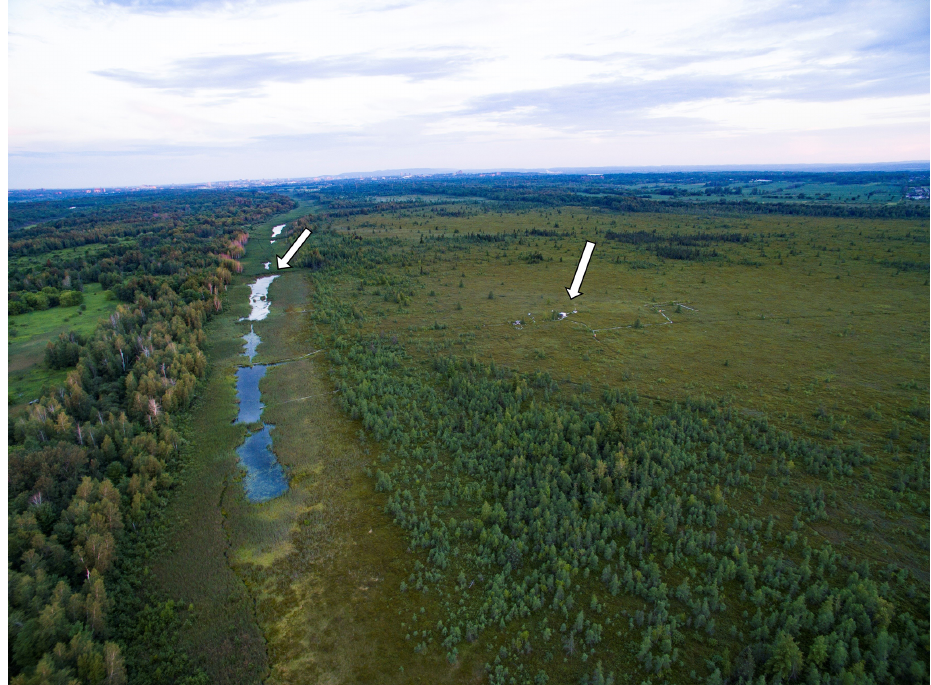
Figure 1. Oblique photograph of the northeastern portion of the Mer Bleue bog. Arrows indicating the location of the beaver pond and its dam (left) and the tower (right) (Photo courtesy of Professor Margaret Kalacska, photo credit Olivier Lucanus).